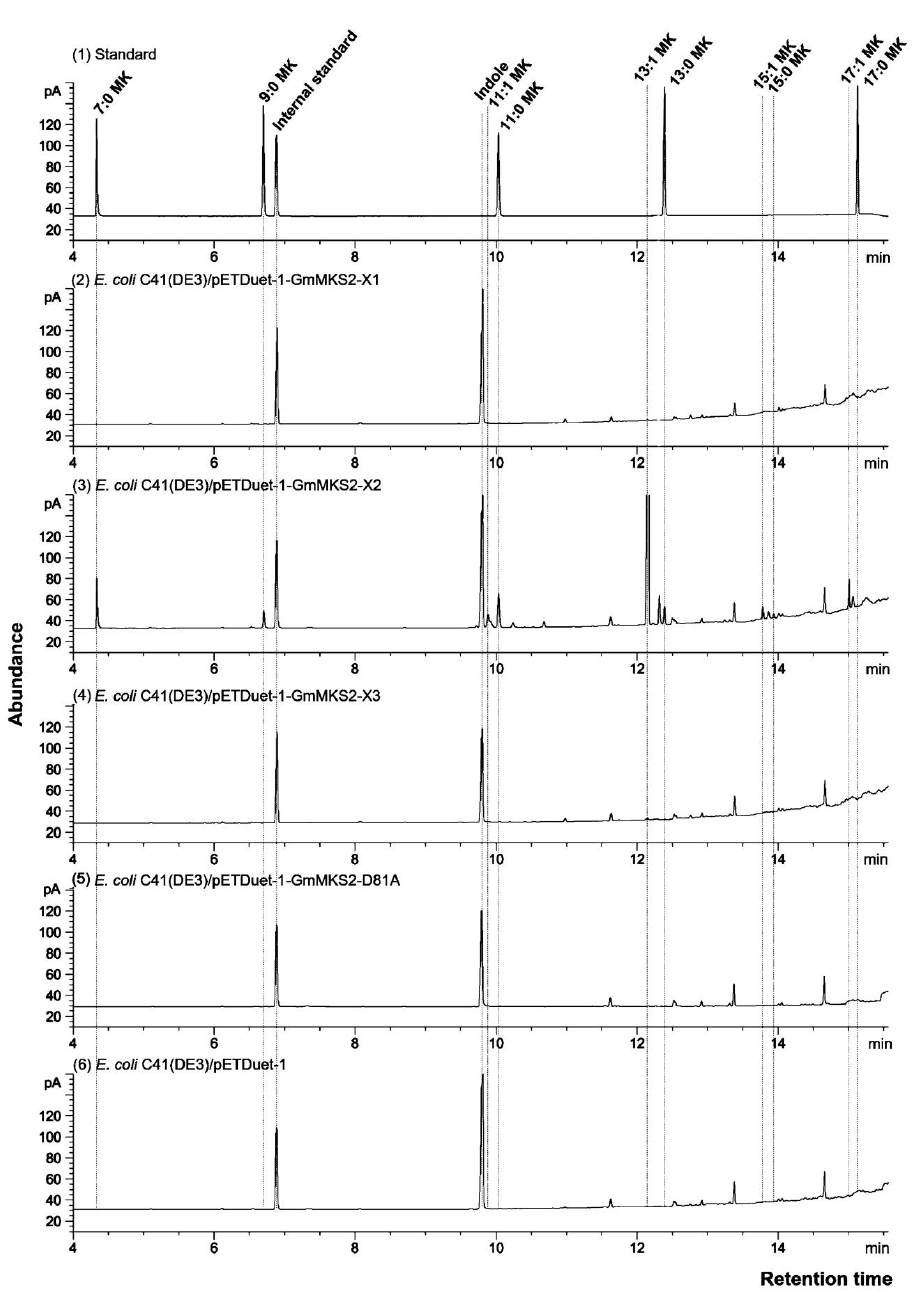
Figure 2. Gas chromatography (GC) analysis of the peaks obtained after heating the culture of Escherichia coli C41(DE3) cells. Cells carried an empty vector (pETDuet-1) ( 6 ) or expressed GmMKS2-X1 ( 2 ), GmMKS2-X2 ( 3 ), GmMKS2-X3 ( 4 ), or GmMKS2-X2-D81A ( 5 ). Peaks were identified by mass spectrometry (MS), and their retention times were compared to those of authentic standards ( 1 ). Cells were grown, and cultures were collected and treated as described in “Materials and Methods”. Linalool was added as an internal standard before extraction.